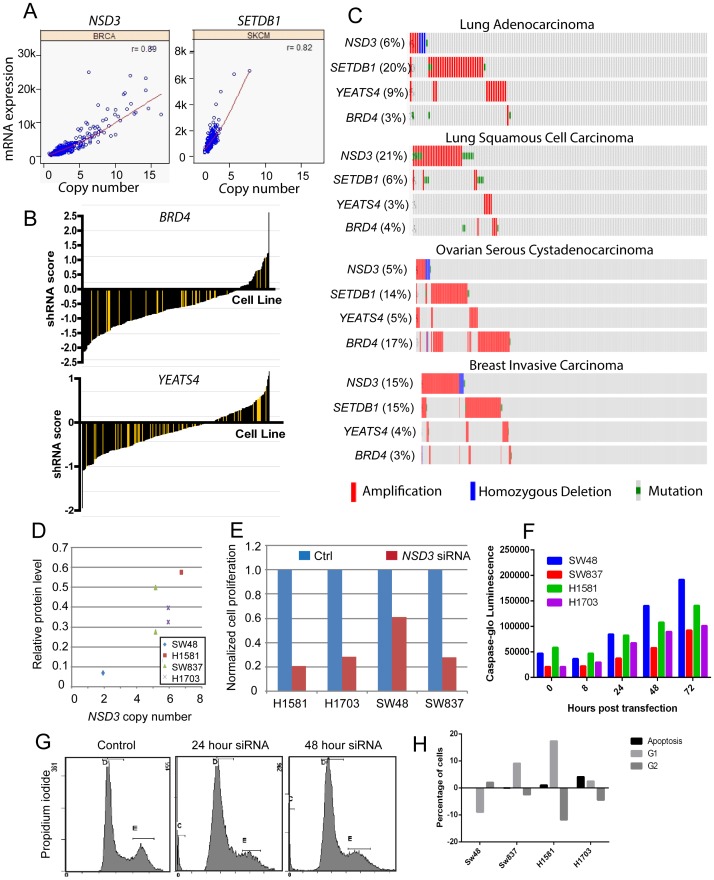
Epigenetic regulatory genes as putative cancer amplified driver genes.(A) Copy number (x-axis) and mRNA expression (y-axis) for NSD3 and SETD1 in breast cancers and melanomas, respectively. Correlation coefficient for copy number and mRNA expression are listed in the top right (r value). (B) BRD4 and YEATS4 shRNA activity in a panel of cancer cell lines (Project Achilles). shRNA score denotes the log2 based decrease in the representative shRNA compared to pooled shRNA in cancer cell lines after several rounds of proliferation post-shRNA [11]. Yellow bars indicate cell lines with BRD4 or YEATS4 copy number >4 and black bars indicate cell lines with BRD4 or YEATS4 copy number <4. (C) Frequency of amplification (red bar), mutation (green bar), and deletion (blue bar) for NSD3, SETDB1, YEATS4, and BRD4 in various cancers. The percentages shown reflect the overall rate of gene amplification, mutation and/or deletion in each cancer type. Vertical aligned bars reflect samples from the same patient. (D) Relative NSD3 protein level (y-axis, normalized to b-actin protein levels) compared with NSD3 copy number (x-axis) in SW48, H1581, SW837, and H1703 cells. (E) Relative proliferation (y-axis) and (F) relative apoptosis levels of cancer cell lines H1581, H1703, SW48, and SW837 cells 3 days after transfection with NSD3 siRNA, as measured by Cell Titer Glo and Caspase Glo assays, respectively. (G) Cell cycle profile of H1703 cells 24 or 48 hours after transfection with NSD3 siRNA compared to non-transfected controls. (H) Relative changes of cells in apoptosis, G1 or G2 phases (y-axis) in cell lines 48 hours-post NSD3 siRNA transfection compared to uninfected controls.